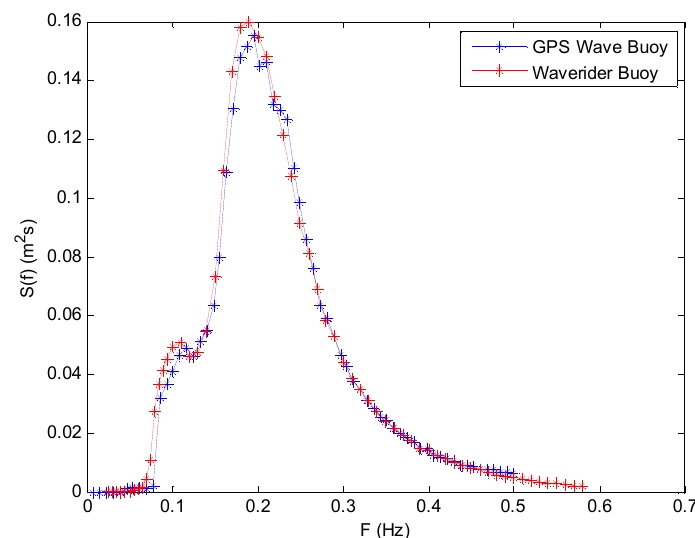
Figure 13. Comparison of average wave frequency spectrum between the SBF7-1A GPS wave buoy and the DWR-MKIII Waverider buoy after correction from 19 June to 3 July 2013. All the directional wave spectrums of the two buoys are first summed and then averaged to obtain an average directional wave spectrum, respectively. Their comparison is shown in Figure 14. Their energy density distribution maps are also very consistent in frequency distribution and direction distribution. The wave energy distributions of the two buoys are all concentrated in the same wave direction range from 90 to 210 degrees.